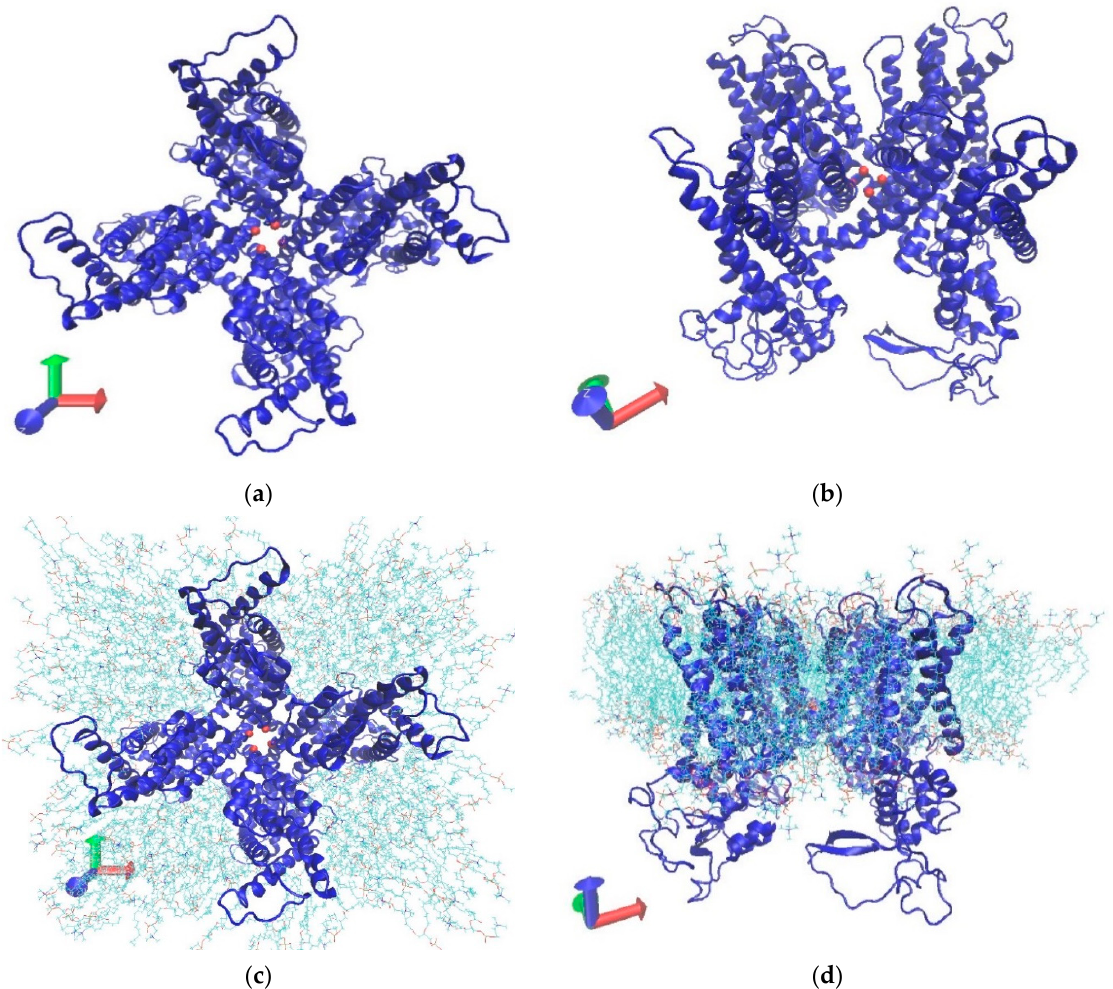
Figure 1. Ribbon diagram of transient receptor potential vanilloid 1 (TRPV1). ( a , c ) A top and ( b , d ) a side view of ( a , b ) TRPV1 only and ( c , d ) membrane-embedded models expressed as VMD software. Protein parts are shown as “NewCar-toon” and lipids are shown as “Lines.” For clarity, water and ion molecules have been omitted in this picture. The channel is seen at the center of panels ( a ) and ( c ). Lower gates (I679) are shown as red beads.